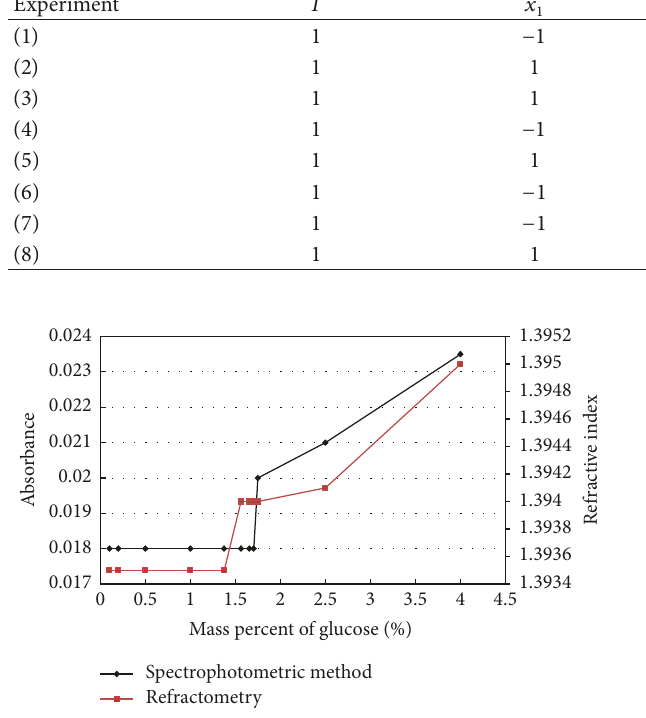
Figure 3: Influence of glucose on absorbance and refractive